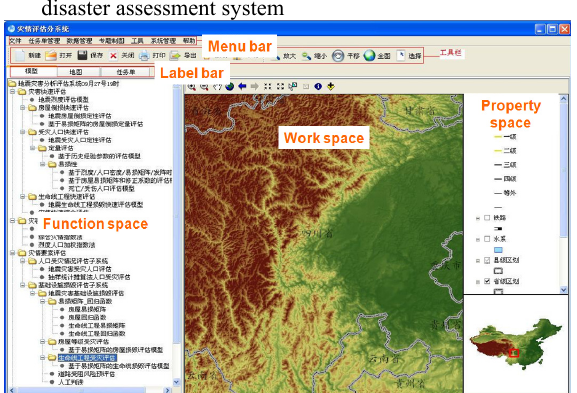
Figure 3: Graphical user interface of the disaster assessment